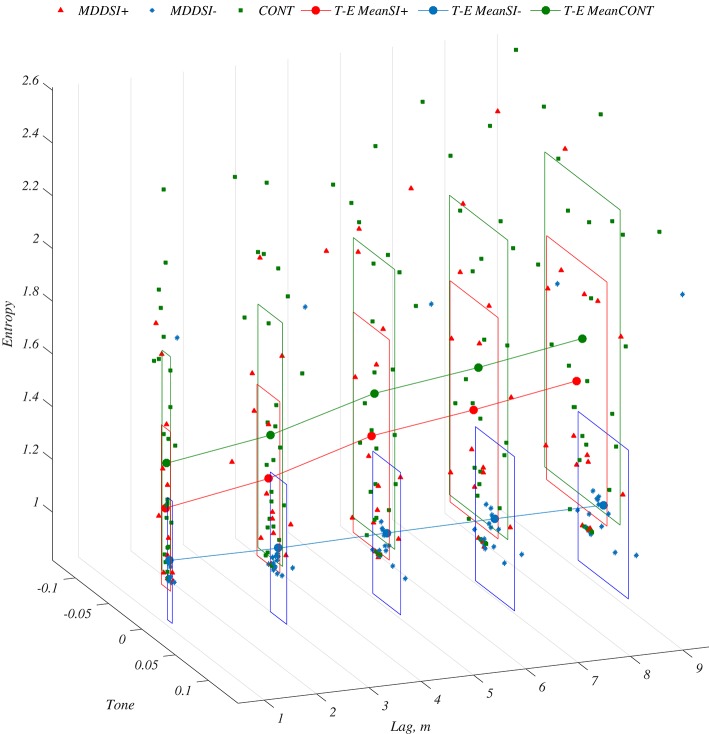
Visualization of multi-lag tone and entropy (T-E) features extracted from Diastole series at 3D plot corresponding to MDDSI+ (Δ), MDDSI− (■), and CONT (•) groups respectively, along with rectangles representing Mean ± SD.